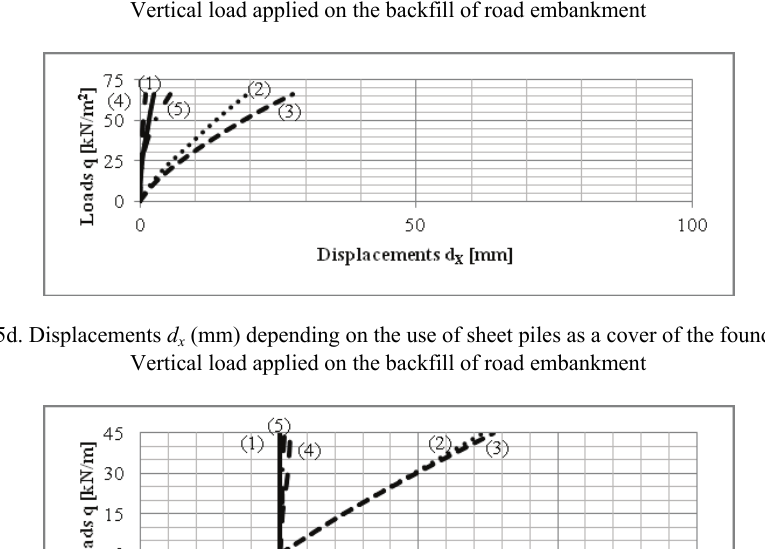
Fig. 5c. Displacements d 2 (mm) depending on the use of sheet piles as a cover of the foundation. Vertical load applied on the backfill of road embankment